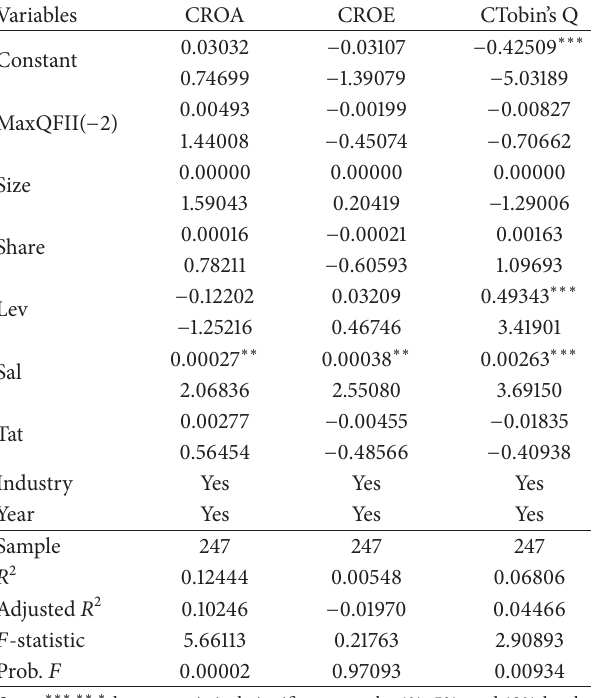
Table 7: Regression results of QFII ratio in period ( 𝑡 − 1 ) and company performance improvement according to MODEL III.